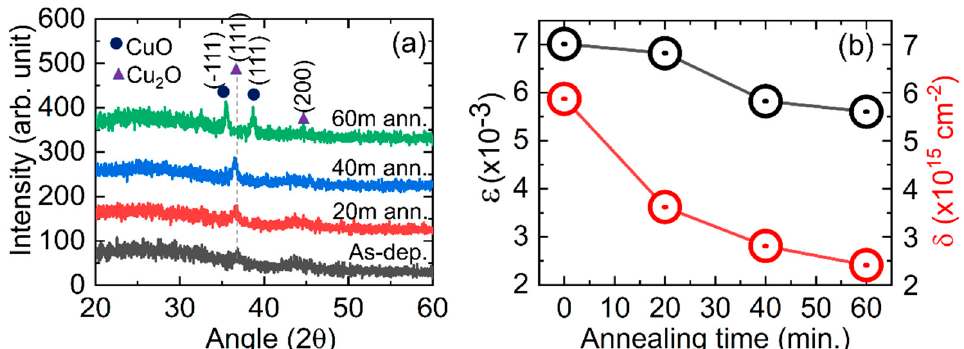
Figure 1. ( a ) X-ray Diffraction (XRD) patterns of Cu x O thin films prepared in this study and ( b ) estimated micro-strain ( ε ) and dislocation density ( δ ) in the films.